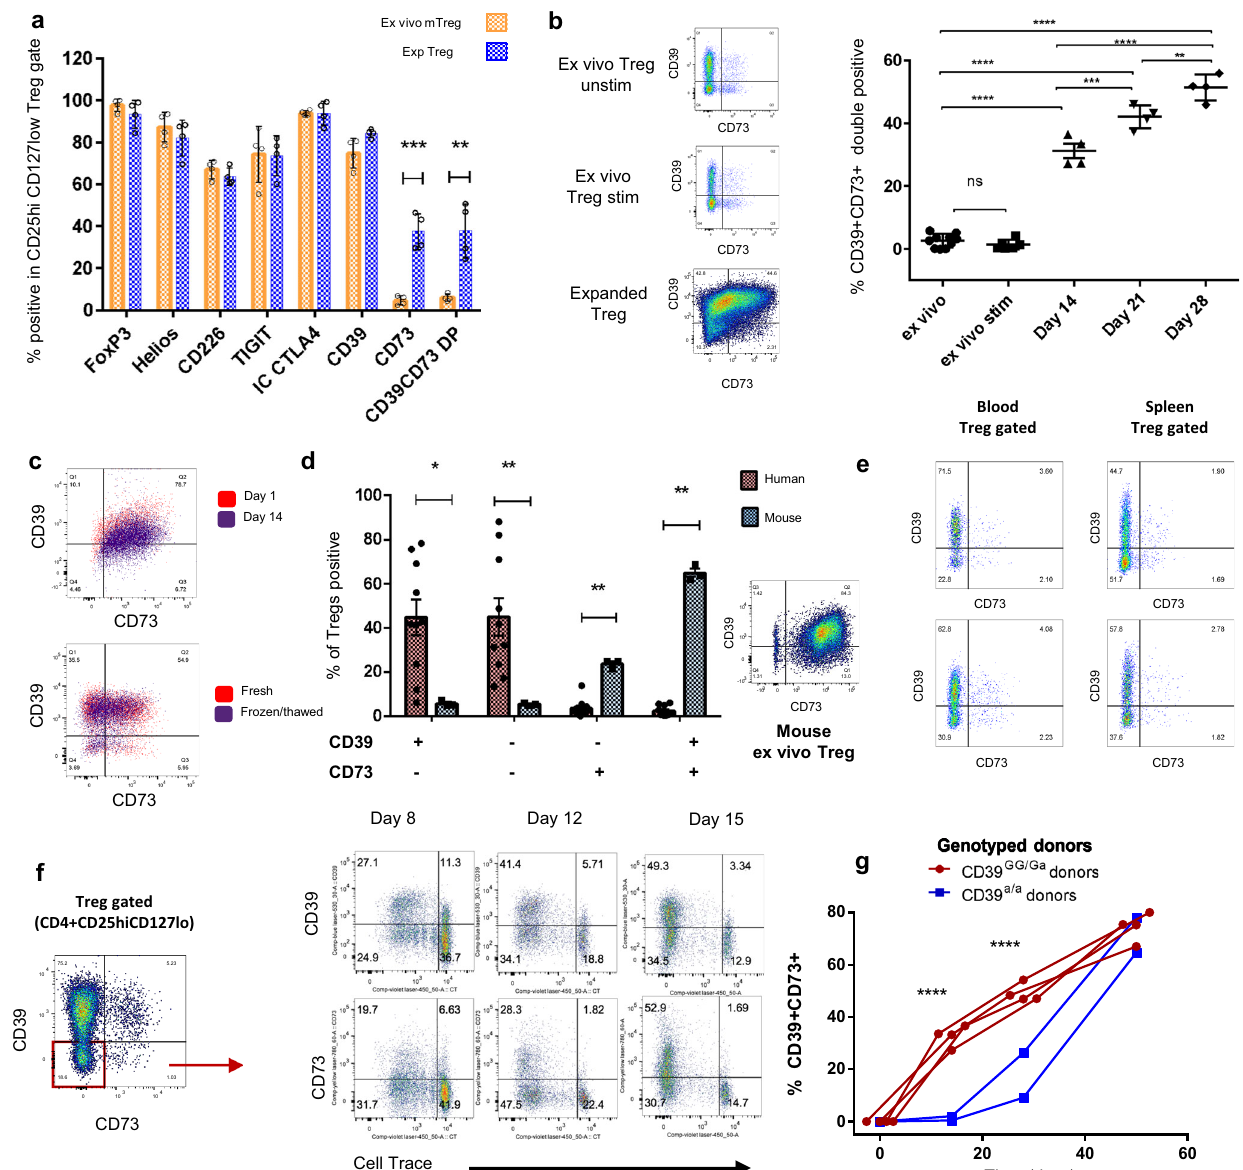
Fig. 2 expTregs acquire stable CD73 expression and become CD39/CD73 co-expressing during their expansion. a Mean percent expression (±1SD) of Treg-associated markers expressed by resting expTreg ×2 (blue bars) and ex vivo mTregs (orange bars) from four donors (multiple t -tests with Holm – Sidak correction for multiple comparisons). b Representative dotplots of CD39/CD73 co-expression in ex vivo Tregs, stimulated ex vivo Tregs and expTregs. Percentage expTreg CD39 + CD73 + expression in ex vivo Tregs, stim ex vivo Tregs and expTregs from four donors over time (one-way ANOVA followed by Tukey ’ s multiple comparison testing). c Top plot: CD39/CD73 expression on fl ow-sorted expTregs rested for 1 day vs. expTregs rested for 2